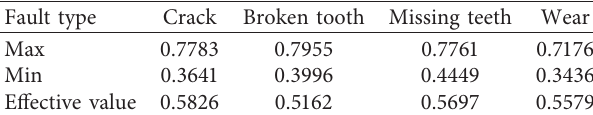
Figure 9: The original signal calculated MMSDE value changes with scale. Table 1: MMSDE value of original